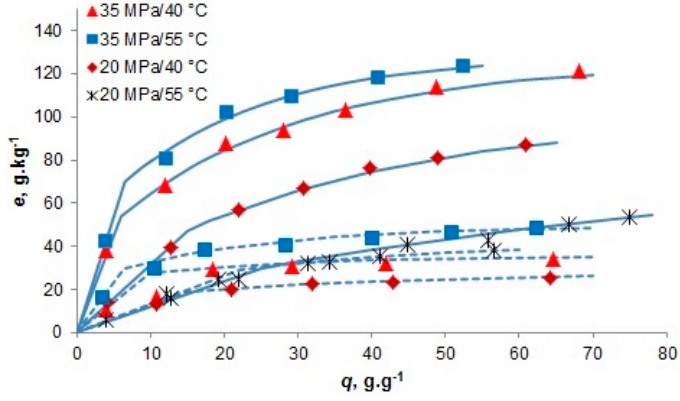
Figure 4. Oil extraction from Chlorella vulgaris [7] with scCO 2 at q’ = 0.16 min − 1 . The feed was N = 5 g. Full lines: crushed alga, dashed lines: whole alga.